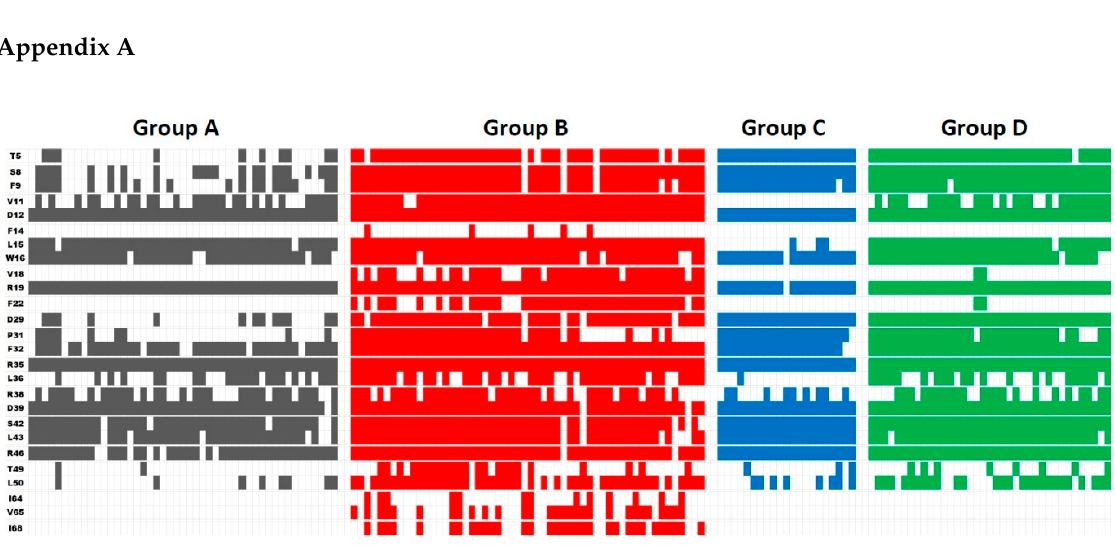
Figure S1: Secondary structure map for FL and RBD simulations; Figure S2: Distribution of the four groups of groove pockets along the MDs; Figure S3: RBD conformations representative of the four groups of pockets; Table S1: The 17 pocket descriptors. PDB coordinates of representative pockets from the 4 groups.